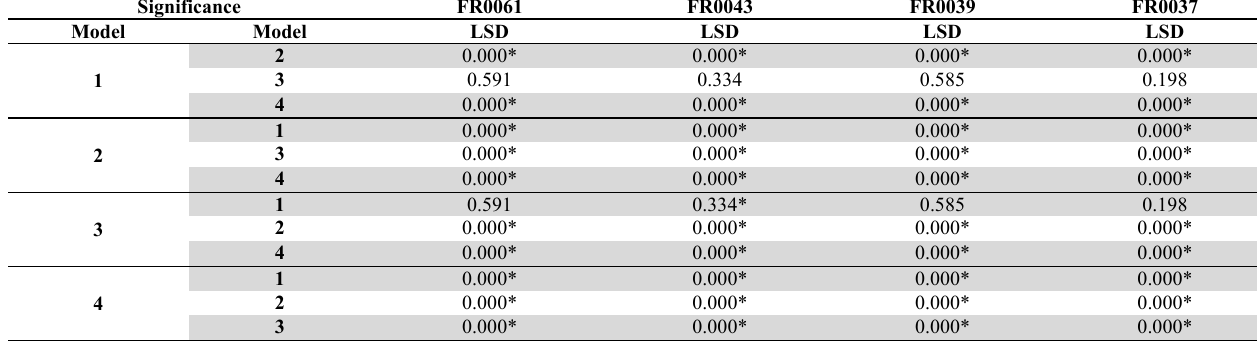
Post Hoc Least Significant Difference (LSD)